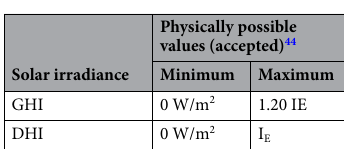
Table 4. Physically possible minimum and maximum values for each measurement of solar